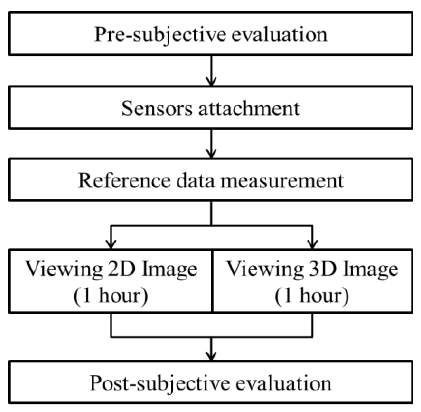
Figure 1. Experimental procedure.